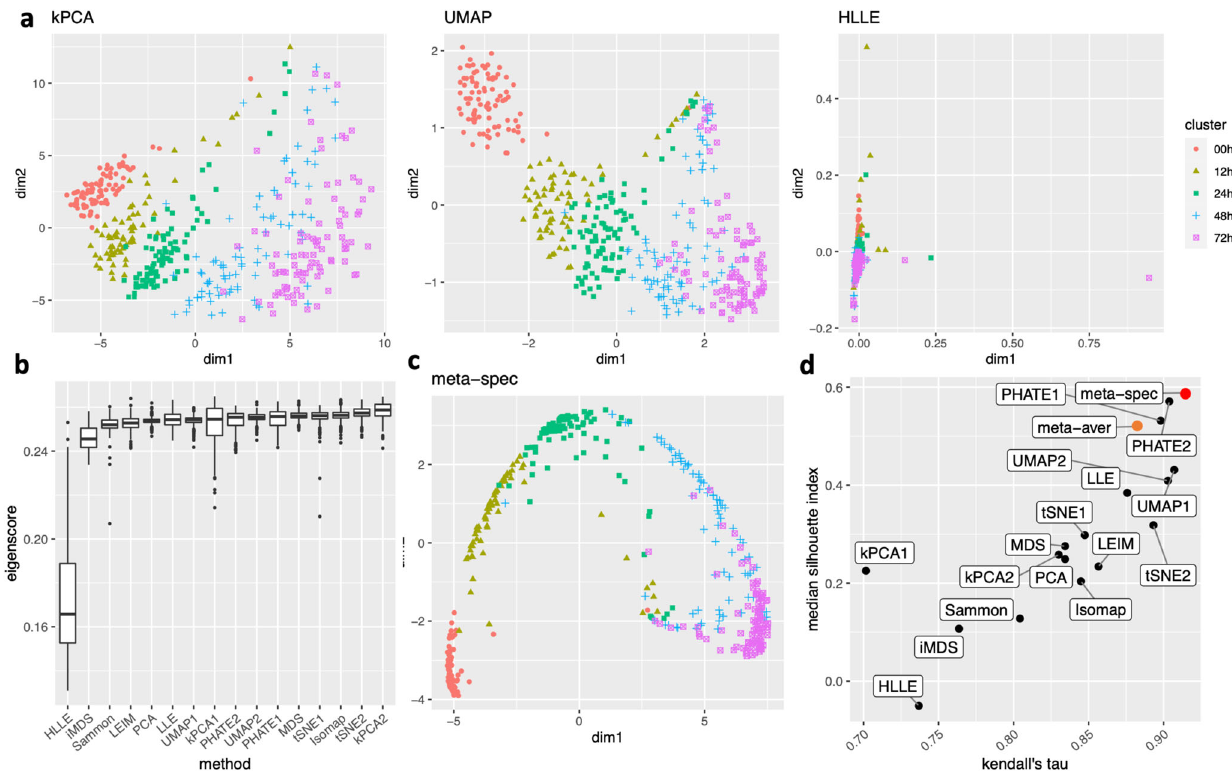
Fig.5|Visualizationof421cellsundergoingdifferentiation.a Threeexamplesof candidate visualizations. The individual cells are marked by fi ve different symbols and colors according to the time points they were captured and sequenced. More examples are included in Supplementary Fig. 11. b Boxplots (center line, median; box limits, upper and lower quartiles; points, outliers) of eigenscores for all 16